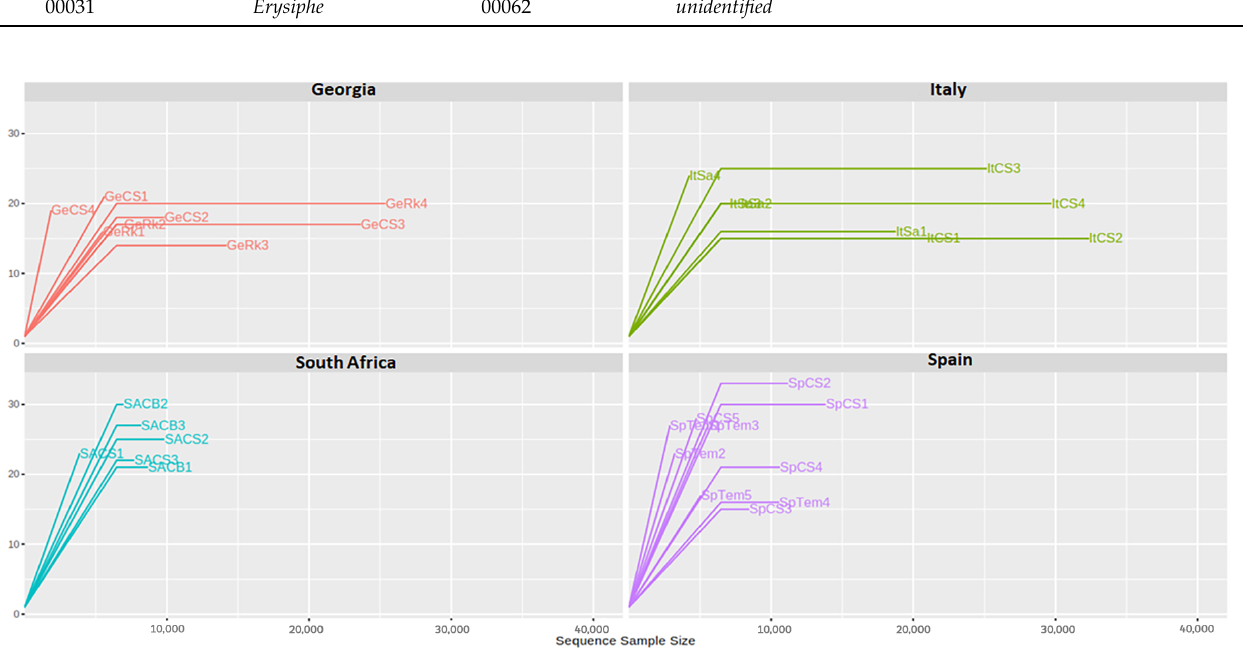
Figure A1. Sampling depth and sequencing coverage analyzed by rarefaction curves for the Shannon index for each sample in each country.